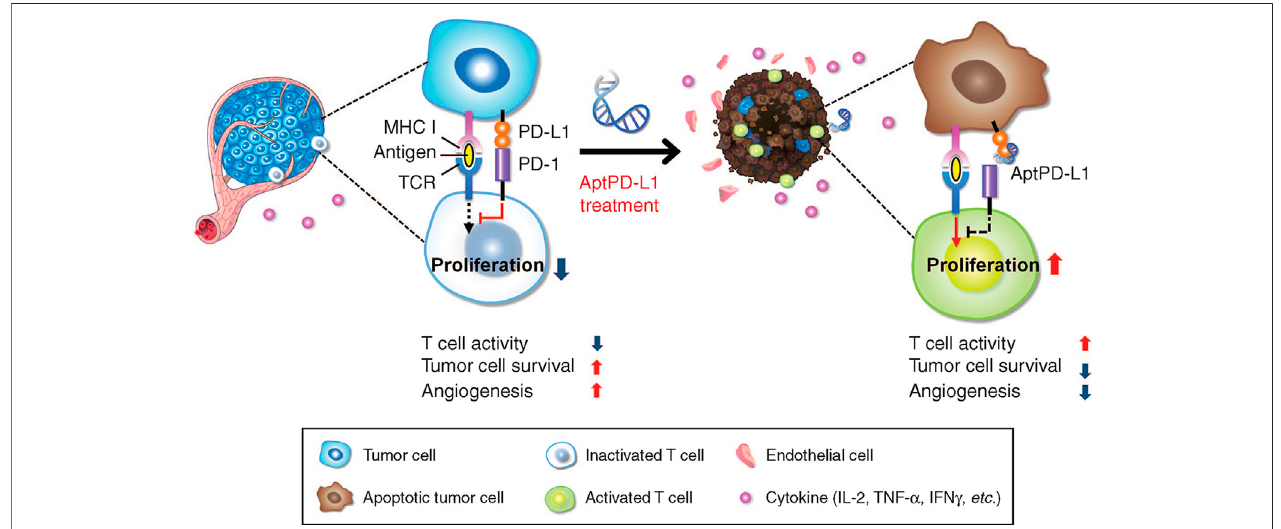
FIGURE 2 | APTPD-L1 can inhibit the PD1/PDL1 interaction and weaken the inhibition of T cells (Lai et al., 2016).